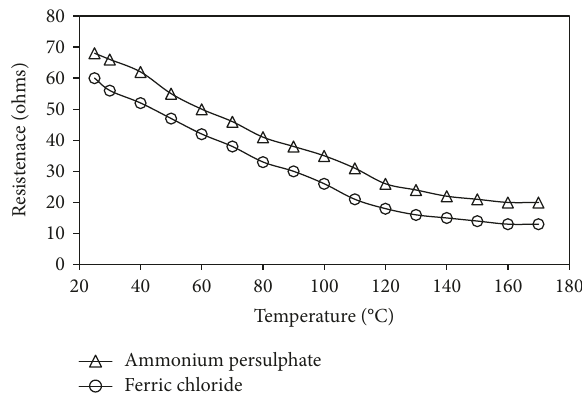
Figure 1: Resistance versus temperature for di ff erent oxidants (pyrrole 0.05M and 0.1 M oxidants at 25 ° C, duration 4 hrs, and surfactant